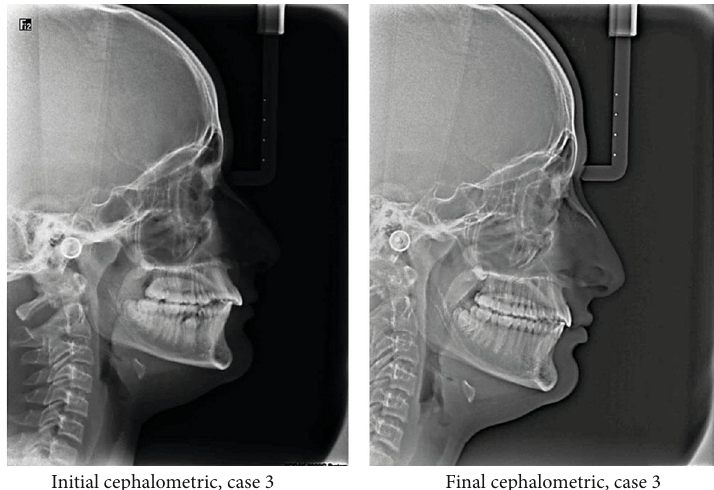
Figure 19: Initial and fi nal cephalometric radiographs.